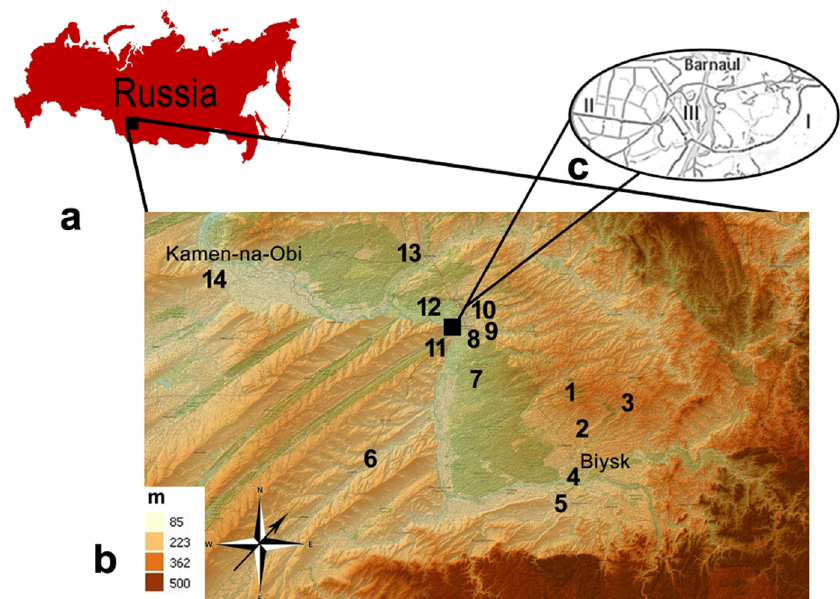
Figure 1. ( a ) Location of the studied area; ( b ) snowpack sampling network. The sampling points are the numbers 1–14; ( c ) location sites for conducting experiments (I, II) and atmospheric precipitation sampling (III).